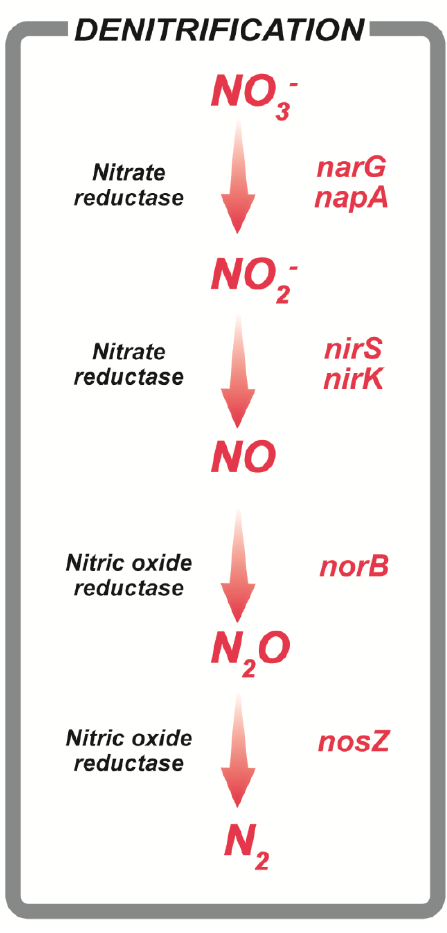
Figure 1. Genes related to denitrification in the nitrogen cycle.